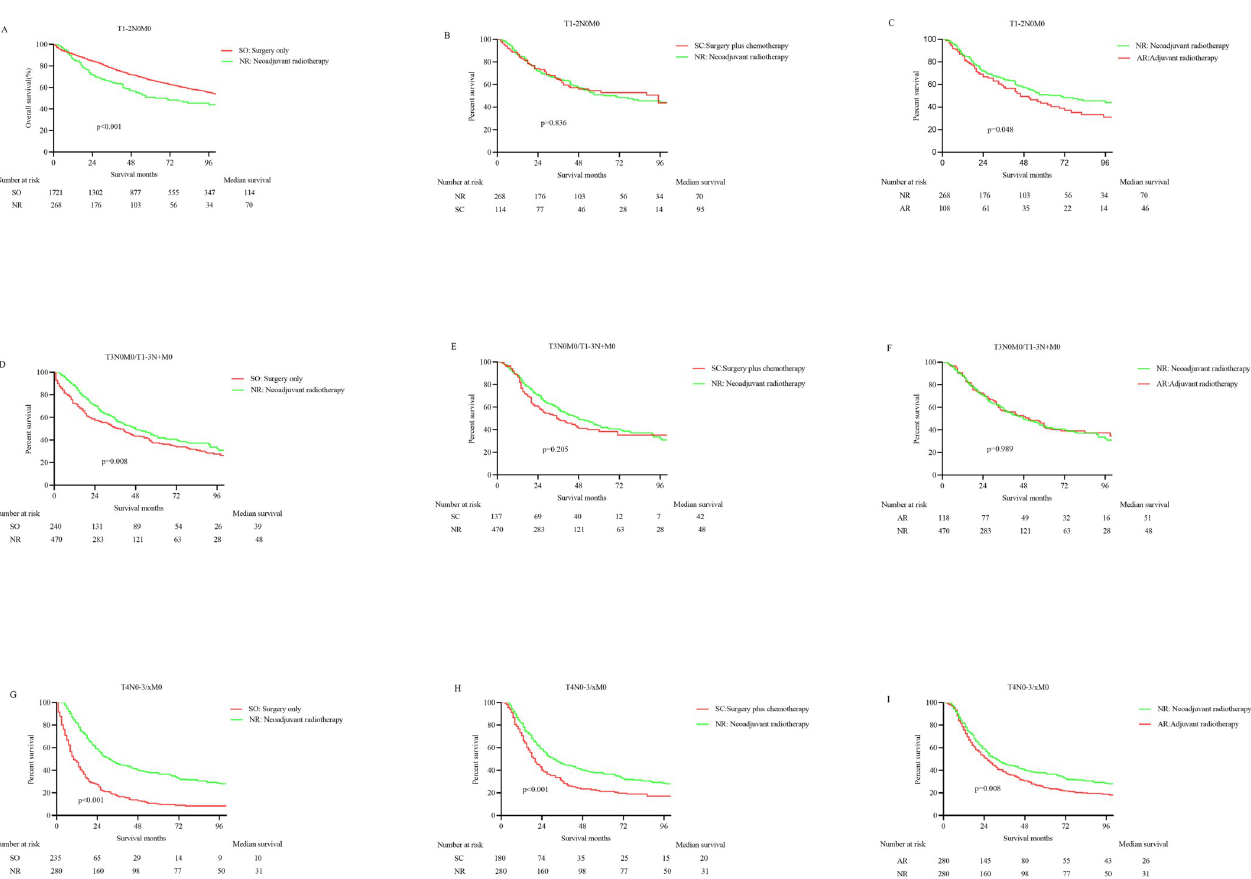
Fig 3. The K-M curves for OS in non- metastatic Siewert type II EGA patients at different stages before PSM. A. Surgery only vs Neoadjuvant radiotherapy in T1-2N0M0; B. Surgery combined with chemotherapy vs Neoadjuvant radiotherapy in T1-2N0M0; C. Neoadjuvant radiotherapy vs Adjuvant radiotherapy in T1-2N0M0; D. Surgery only vs Neoadjuvant radiotherapy in T3N0/T1-3N+M0; E. Surgery combined with chemotherapy vs Neoadjuvant radiotherapy in T3N0/T1-3N+M0; F. Neoadjuvant radiotherapy vs Adjuvant radiotherapy in T3N0/T1-3N+M0; G. Surgery only vs Neoadjuvant radiotherapy in T4; H. Surgery combined with chemotherapy vs Neoadjuvant radiotherapy in T4; I. Neoadjuvant radiotherapy vs Adjuvant radiotherapy in T4.